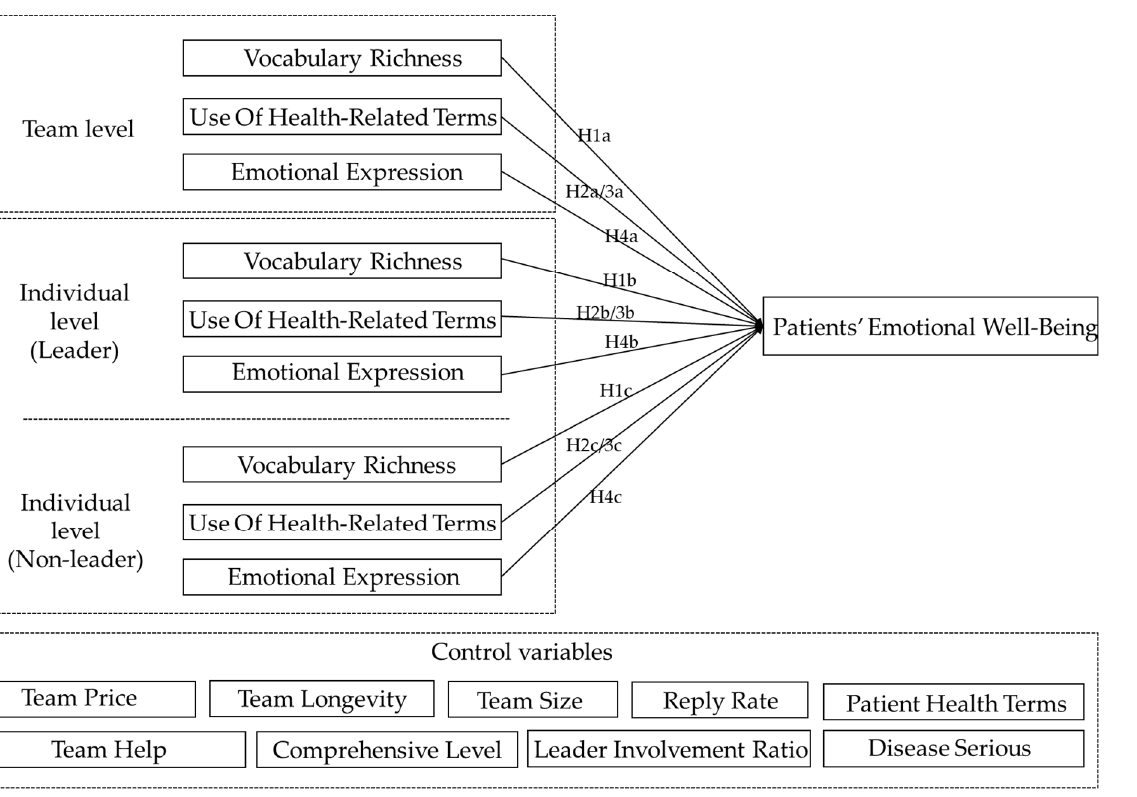
Figure 1. Research model on the influence mechanism of patients’ emotional well-being in online doctor teams .